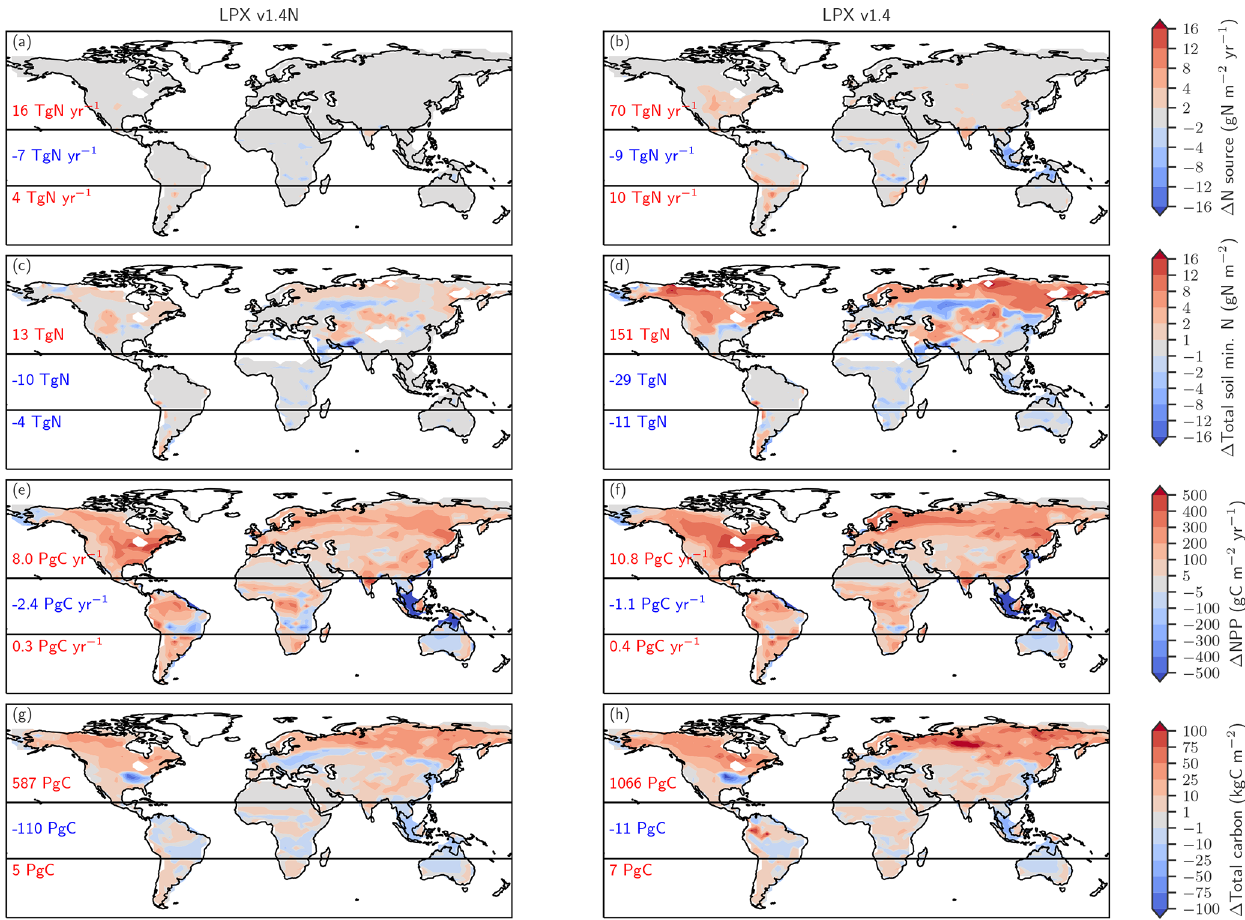
Figure A2. Comparison of model version LPX-Bern v1.4N (left) versus version v1.4 (right) for simulated deglacial changes (0.5ka minus 21ka) in the implied N source (a, b) , bioavailable concentra- tions of ammonium and nitrate in soils (c, d) , net primary produc- tivity (e, f) , and total carbon (g, h)